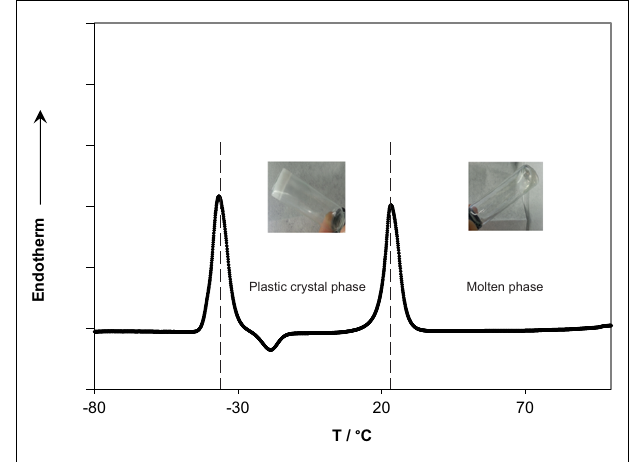
FIGURE 1 | DSC scan and optical images (inset) of the of the SCN-10%TBA-PF 6 electrolyte .